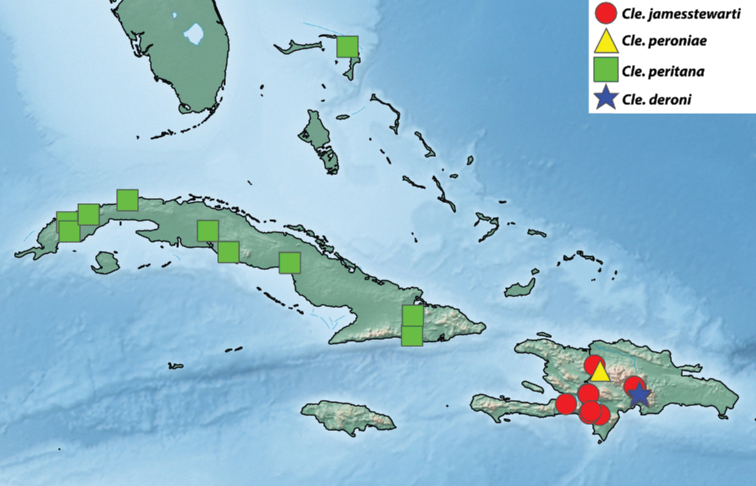
Clepsis species distributions. Legend inset. Florida records of Cle.
peritana omitted.